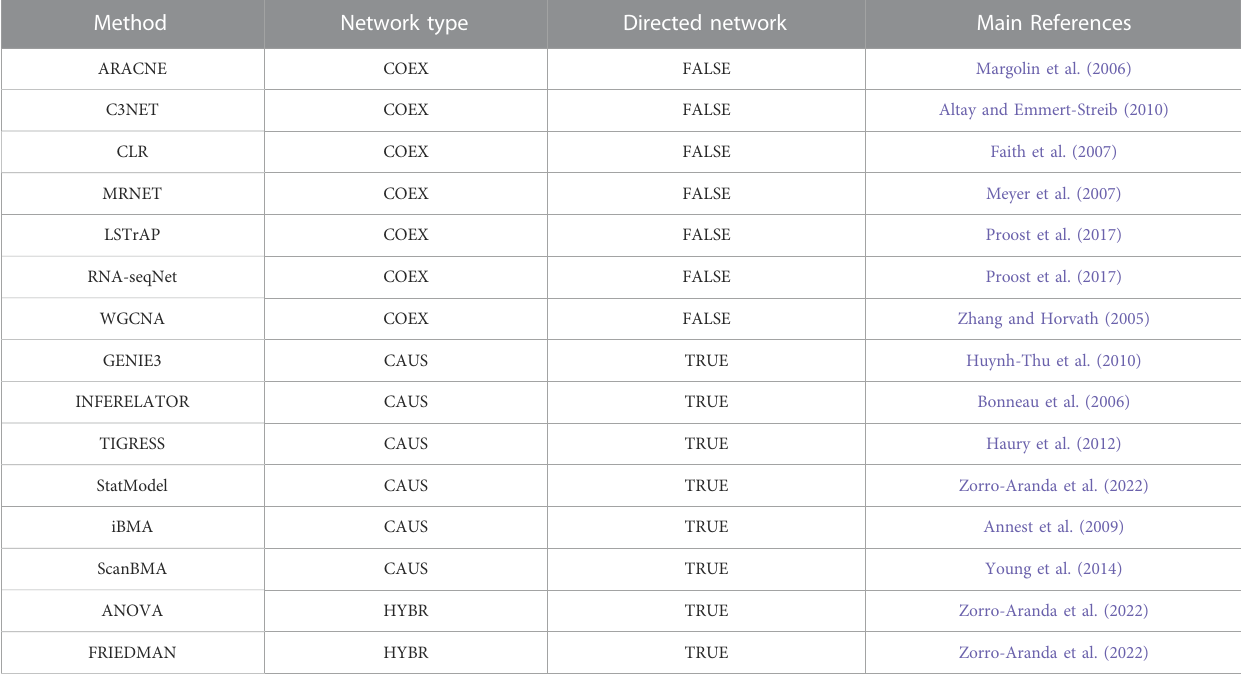
TABLE 1 GRNs inference tools used in this work. For a detailed description of each tool, please see the Supplementary Information. COEX tools infer undirected networks, CAUS tools infer directed networks, HYBR tools infer undirected networks and the direction TF-TG is assigned with the list of known regulators to keep only the TF-mediated interactions (Zorro-Aranda et al., 2022). Community is not listed here because rather than a stand-alone tool, this method integrates the interactions from several single-tool